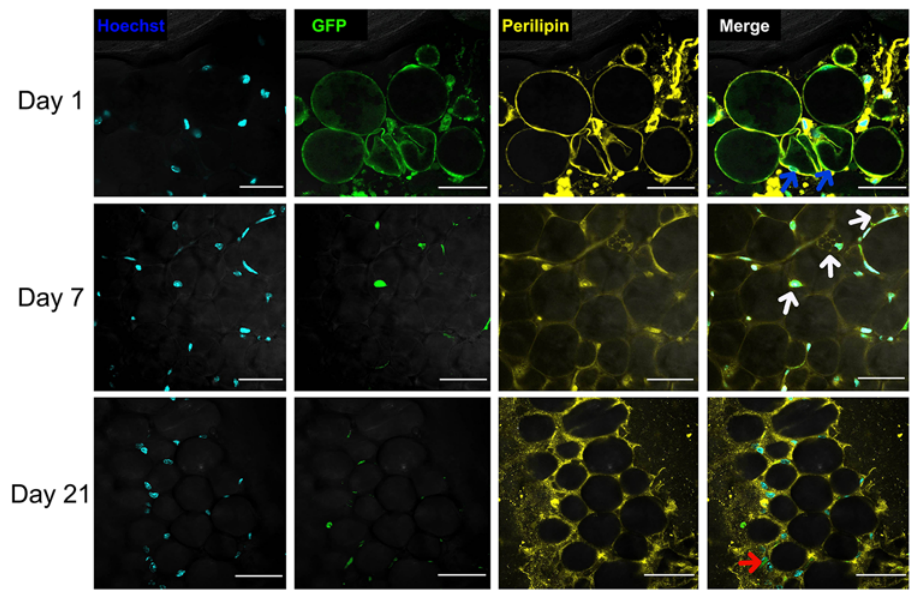
Fig 8. Fate of GFP+ adipocytes after transplantation. On Day 1 after transplantation, some GFP+ adipocytes exhibited membrane contraction (blue arrow). On Day 7, some surviving GFP+ adipocytes had multilocular lipid droplets (white arrow). On Day 21, very few adipocytes survived and those had completely discarded their lipid droplets and changed into fibroblast-like cells (red arrow). Scale bar = 100 μ